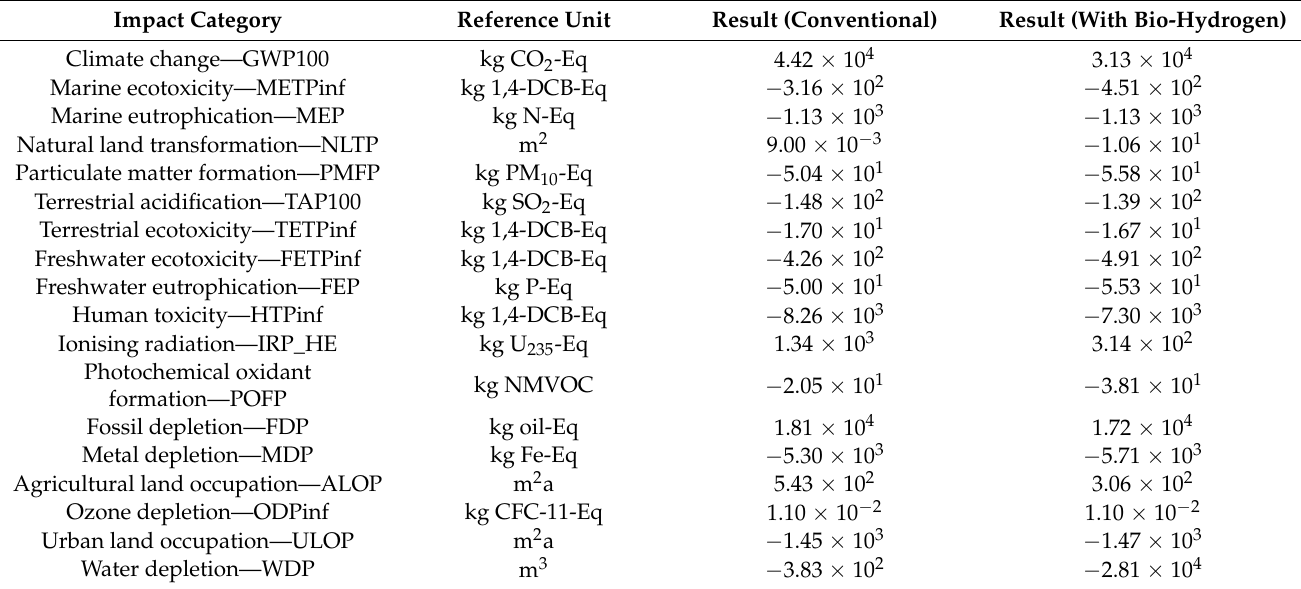
Table 7. Analyzing the life-cycle impacts from